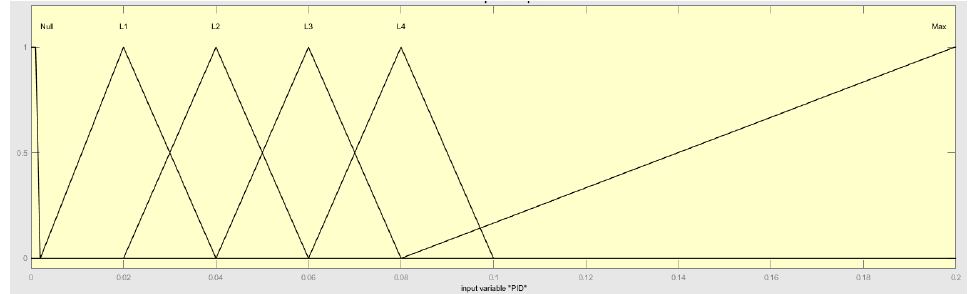
Figure 9. Membership functions of the pitch reference input calculated by the improved PI. Zoom-in on the range [0, 0.20] of the horizontal axis.